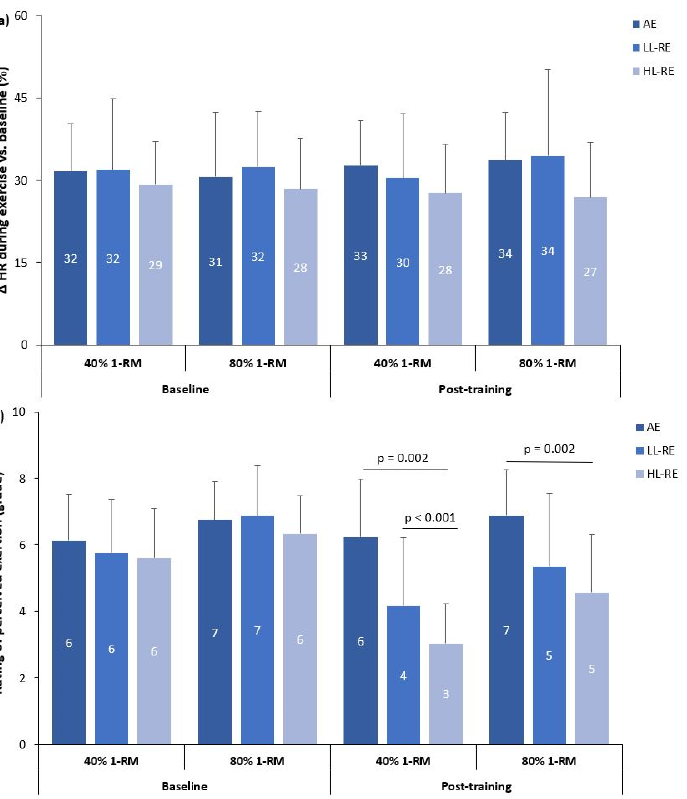
Figure 3. Heart rate ( a ) and exercise tolerance ( b ) adaptations to low-load and high-load resistance exercise. Δ HR: % change in heart rate during the resistance exercise; AE: aerobic exercise, LL-RE: low-load resistance training exercise; HL-RE: high-load resistance exercise.